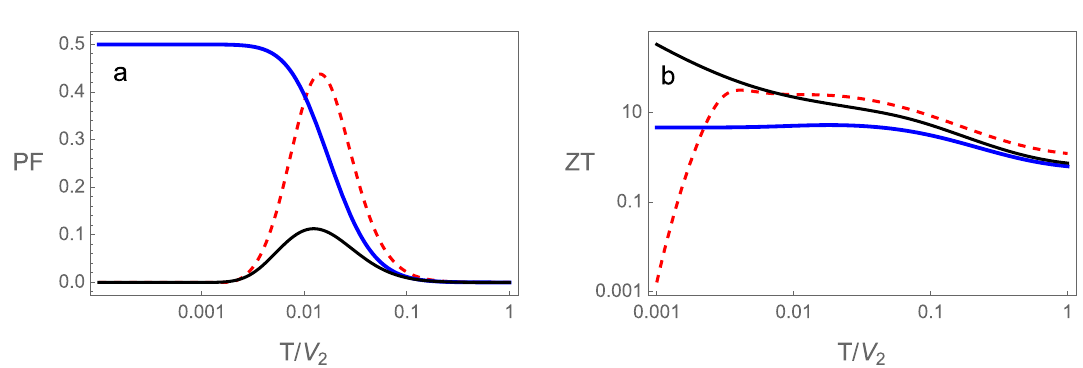
Figure 9. ( a ) Dimensionless electrical conductance, ( b ) thermal conductivity divided by temperature in units of G 0 L 0 and ( c ) Wiedemann–Franz ratio ( WF = ( K / T )/( G / G 0 ) ) in units of G 0 L 0 as functions of temperature for the device with SSH chains. In the trivial phase ( ˜ V = 1.03 ) black continuous, topological phase ( ˜ V = 0.97 ) red dashed and at the topological transition ( ˜ V = 1 ) blue